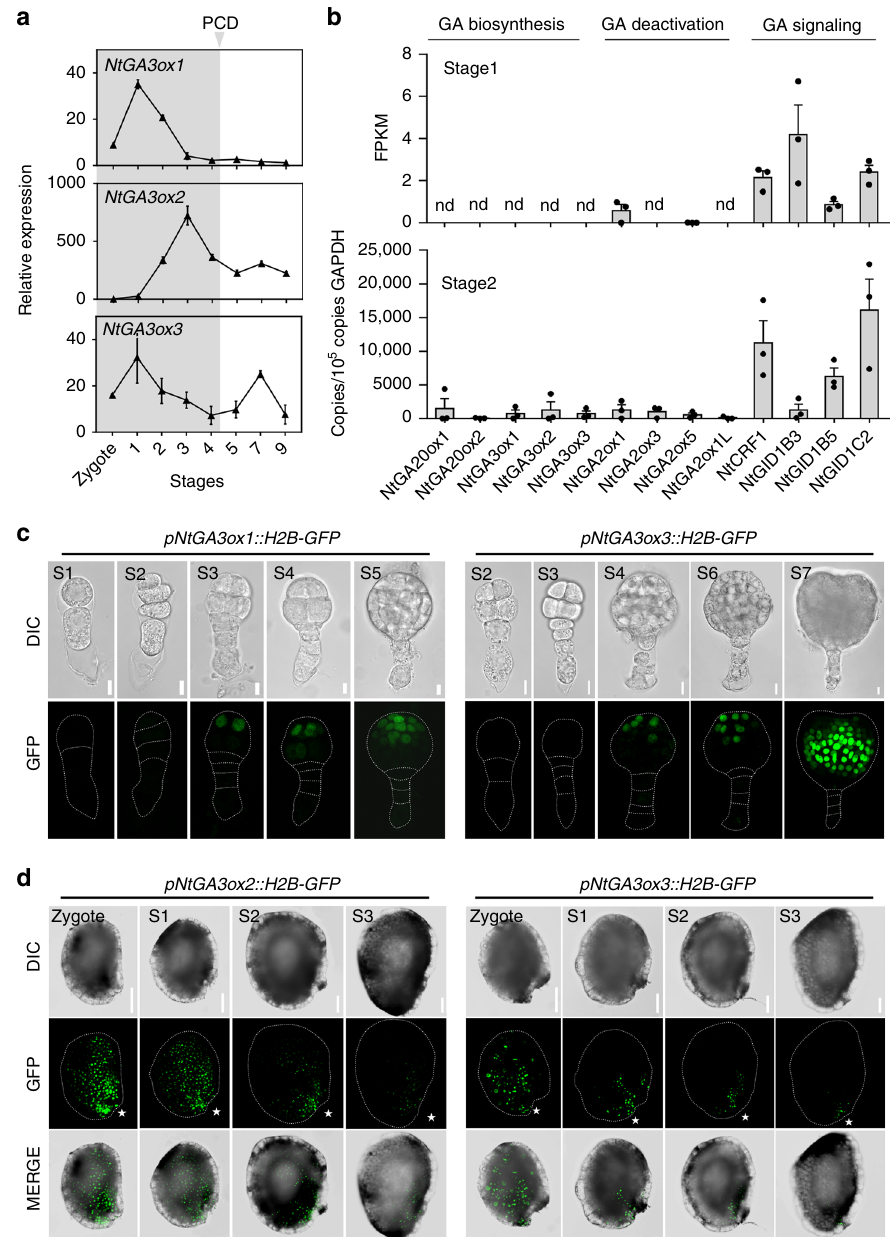
Fig. 4 Bioactive GA biosynthesis during early embryogenesis. a qRT-PCR analysis of NtGA3ox1 , NtGA3ox2 and NtGA3ox3 expression; GAPDH was used as the internal control. b Expression of genes related to GA biosynthesis [ NtGA20ox1 ( Ntc12 , AB012856.1) and NtGA20ox2 ( Ntc16 , AB016084.1)], deactivation [ NtGA2ox1 (AB125232.1), NtGA2ox1-like (XM_016586923.1), NtGA2ox3 (EF471117), and NtGA2ox5 (EF471118)], and signaling in WT two-celled proembryos (stage 1) via transcriptome analysis, and via qRT-PCR analysis in WT four-celled proembryos (stage 2). GAPDH was used as the internal control. Values are means ± SE of three biological replicates. nd, not detected. c Expression of NtGA3ox1 and NtGA3ox3 during embryogenesis. d Expression of NtGA3ox2 and NtGA3ox3 in the developing seed coat. Asterisks, micropylar ends; Scale bars: 10 μ m ( c ), 100 μ m ( d ). The source data of the graphs are provided in